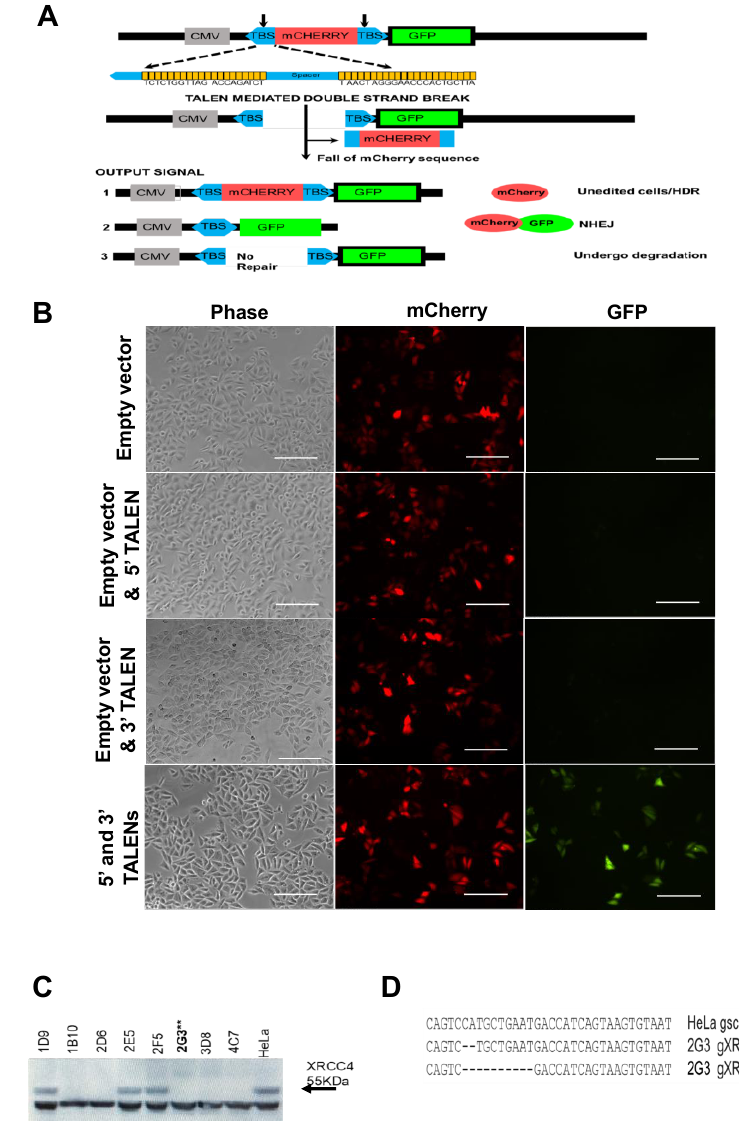
Figure 1. Construction and validation of the repair reporter system. ( A ) Schematic representation of reporter system and plausible outcomes. Outcome signal 1 produces mCherry fluorescence from plasmids that are not edited or are repaired by homology-directed repair (HDR), splicing an unedited fragment from another copy of the plasmid in the cell. Note that for output signal 2, both mCherry and GFP fluorescence would occur because during transient transfection only a fraction of transfected copies of sequences will likely be spliced to eliminate mCherry and express GFP. For output signal 3, if the construct remains unrepaired no fluorescence will be produced for GFP or mCherry. ( B ) Validation of reporter system by fluorescent microscopy identifies transfected mCherry positive cells and reveals repair-induced GFP protein expression when both TALENs are co-expressed. Representative images from triplicate experiments are shown. ( C ) Western blot confirmation of clonal selection of XRCC4 knockout from HeLa cells in clone 2G3** revealed no XRCC4 expression. ** indicates clone used for experiments. ( D ) The XRCC4 gene sequence corresponding to the target region in the 1st exon (nucleotide position 179 – 212th) of XRCC4 for wild-type cells and XRCC4 knockout 2G3 clone. Deletions are indicated by “ - ”. Clone 2G3 contains a frameshift indel on all alleles of XRCC4. Abbreviations: TBS = TALEN binding site; CMV = cytomegalovirus promoter. Scale bar = 100 μm.